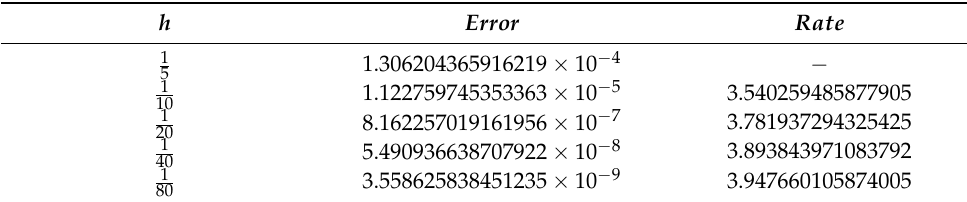
Table 2. Maximum errors and convergence rate as functions with h